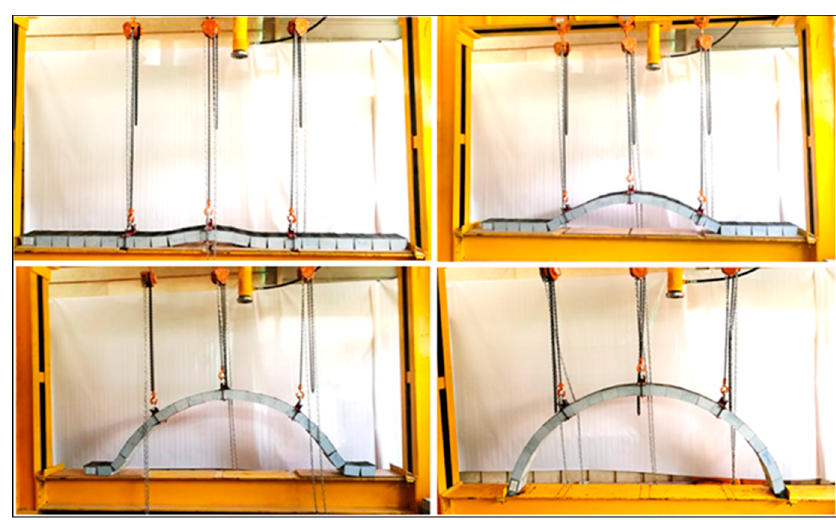
Figure 8. Formation of self-form segmental concrete masonry arches.